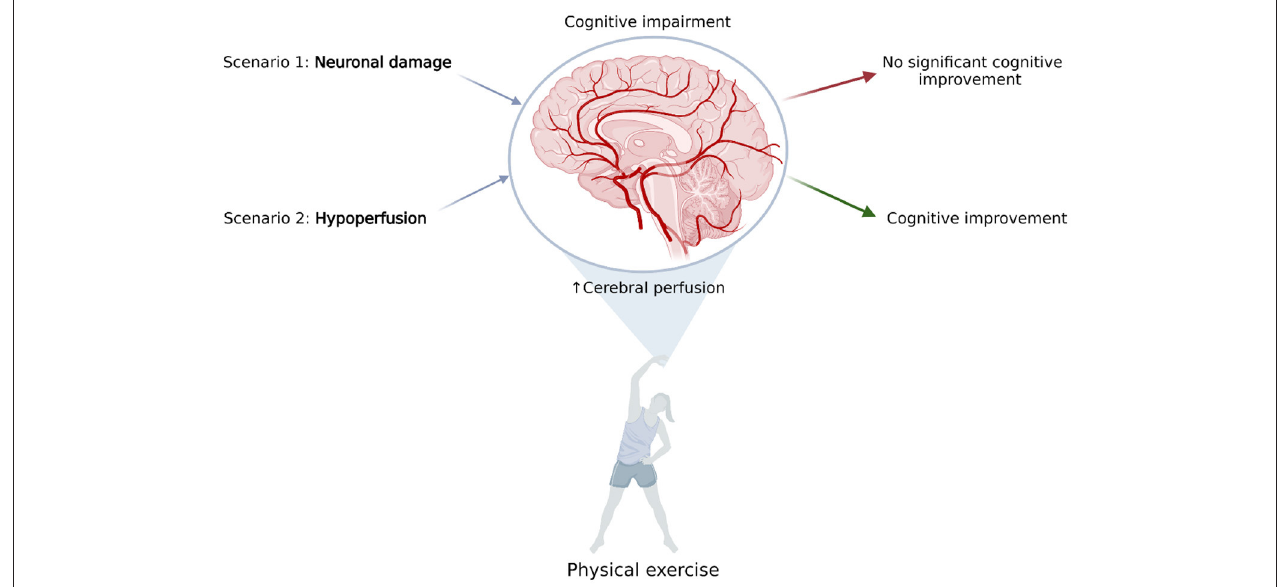
FIGURE 2 | The effect of elevated cerebral blood flow, resulting from physical exercise on common scenarios of cognitive impairment. Scenario 1: Cognitive impairment is caused by neuronal damage; for example, in neurodegenerative diseases. Elevating cerebral perfusion is not efficient due to relative blood oversupply. Scenario 2: Cognitive impairment is caused by hypoperfusion; for example, in vascular disease. Elevating cerebral blood flow may improve patients’ cognitive abilities. Proposed mechanisms have yet to be proved experimentally (Created with